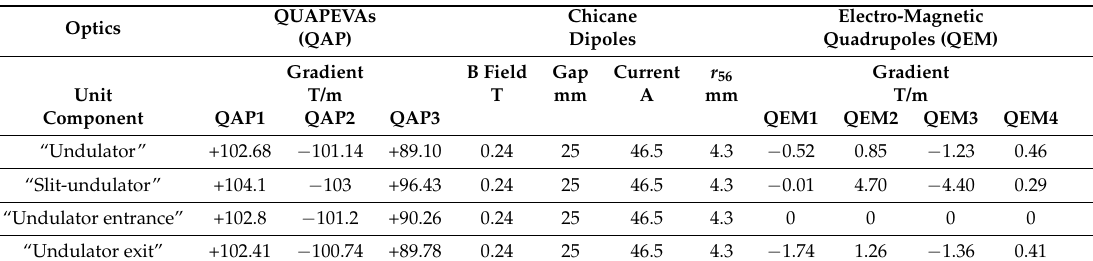
Table 3. Magnetic elements characteristics per optics configuration.